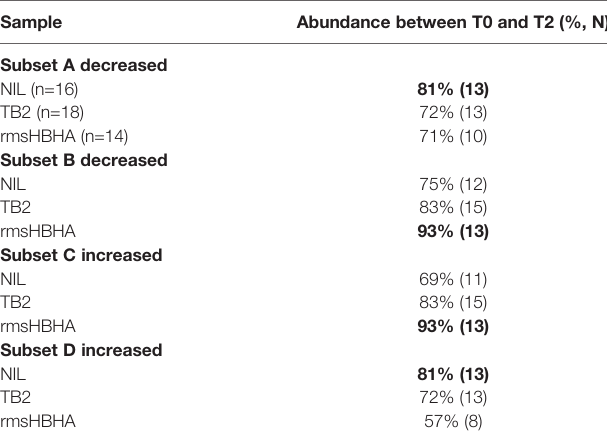
TABLE 1 | Selected subset abundance changes before and after treatment